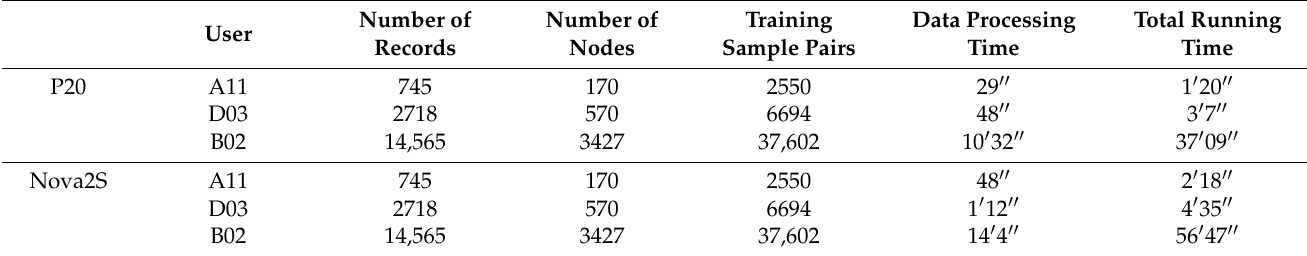
Table 1. Comparison of terminal training